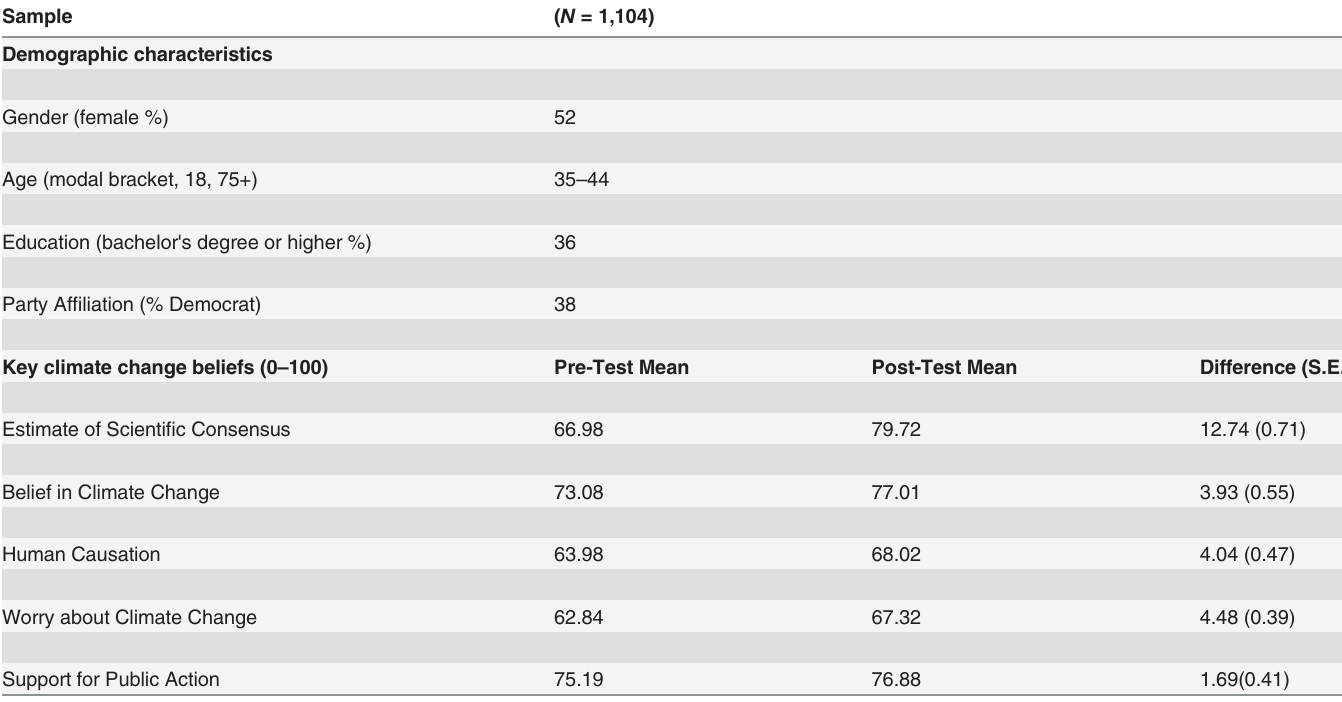
Table 1. Overview of sample characteristics and key belief measures.